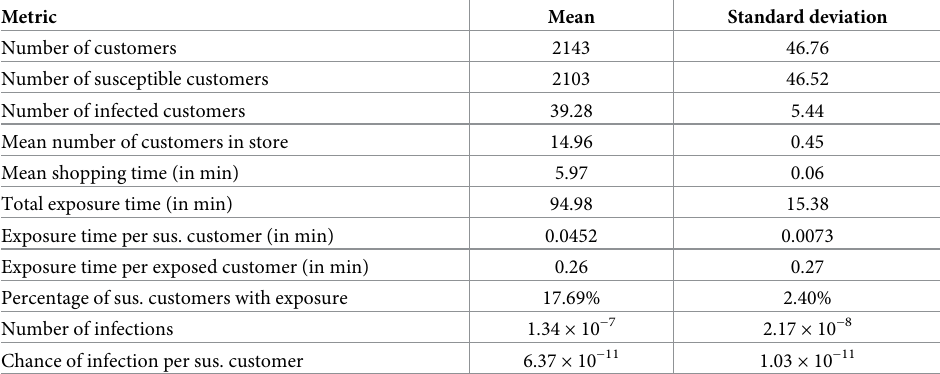
Table 2. Simulation results. We show the mean and standard deviation of each metric across 1000